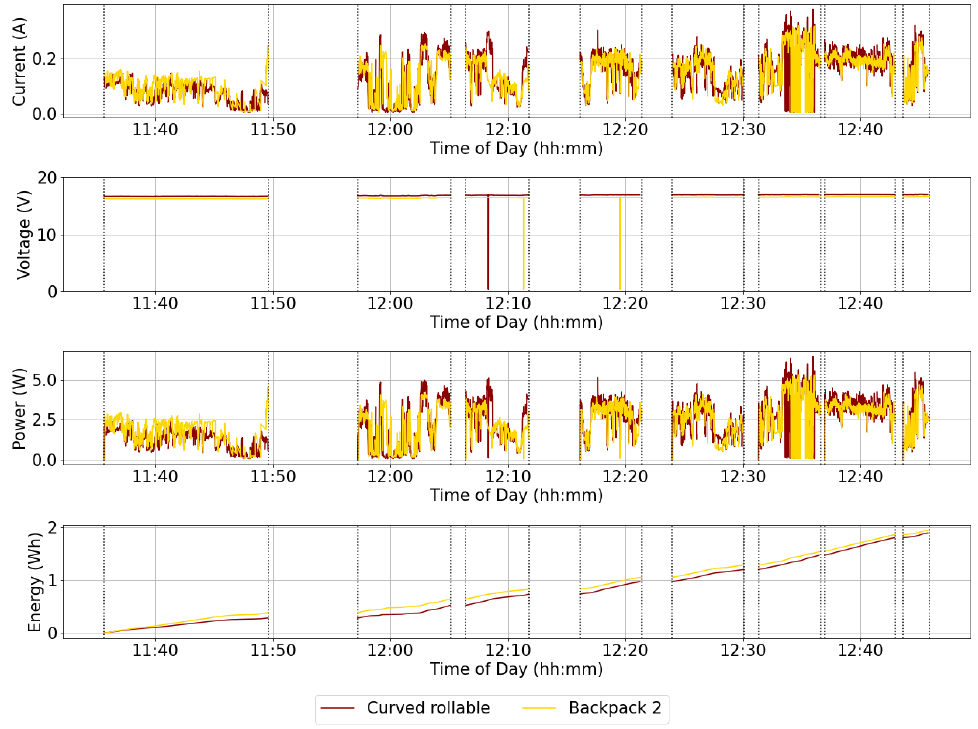
Figure 18. Electrical quantities at the terminals of the battery pack during PV generator tests in real use, small overcast conditions.